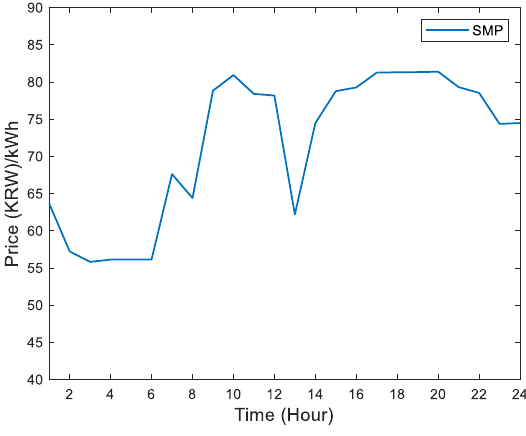
Figure 6. System marginal price.